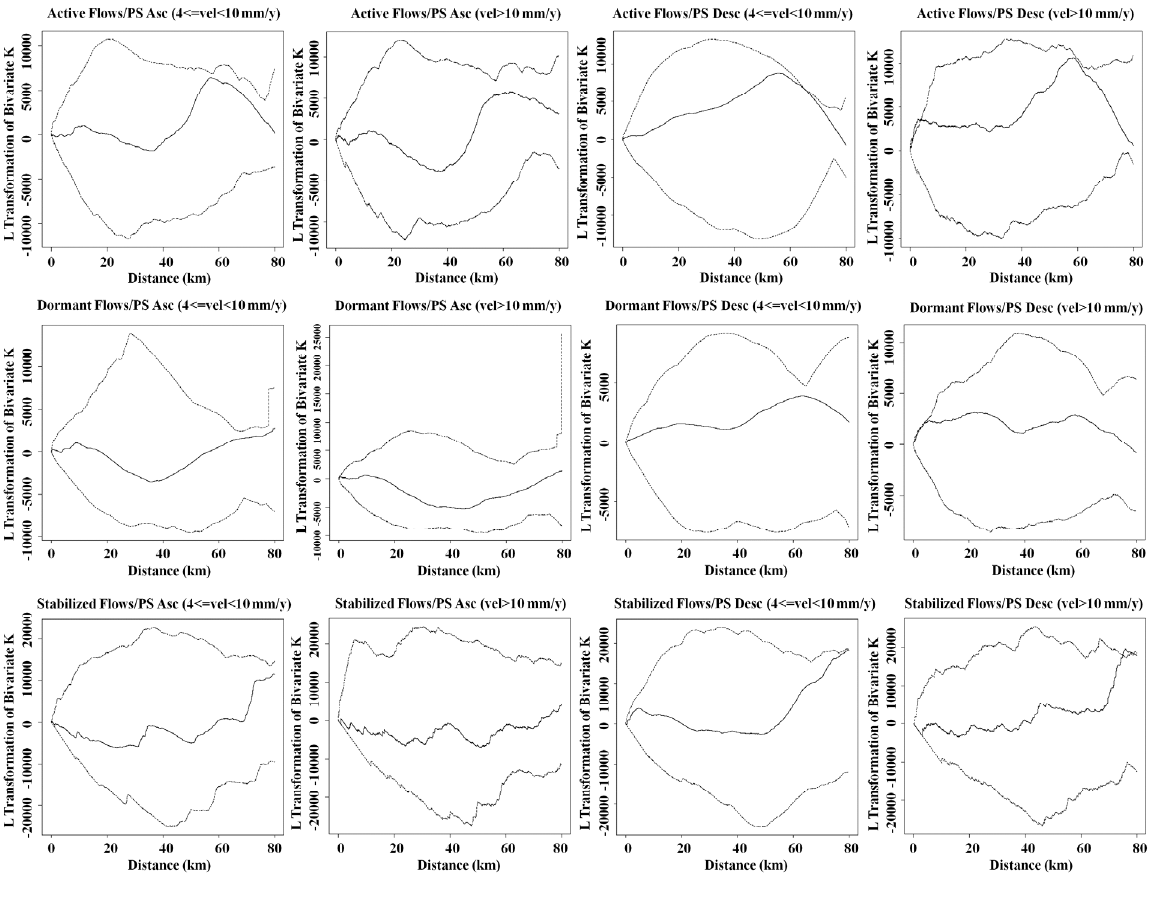
Figure 4. The results of the bivariate K-function analysis for investigating spatial relationships between PS and occurrences of flows in the Arno River basin. Dashed lines delineate 98% confidence intervals and solid lines record the observed values. Observations outside the confidence intervals suggest spatial dependence of clustering ( above ) or repelling ( below ) at corresponding distances. Observations inside the confidence intervals denote spatial